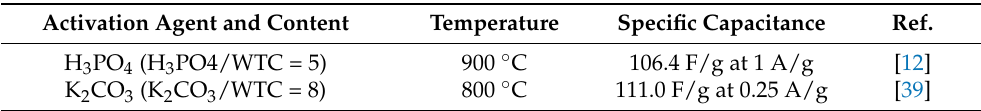
Table 4. Summarizations of waste tire char chemical treatment and relevant